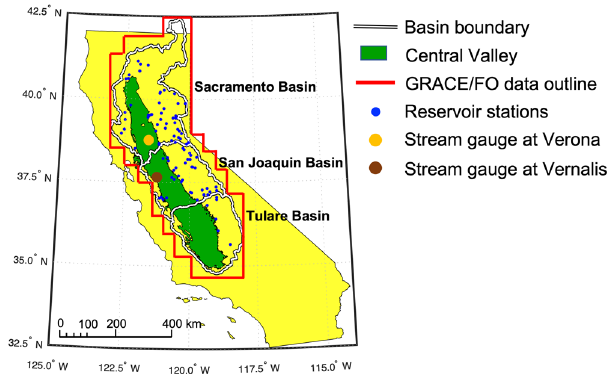
Fig. 1 | California ’ s Central Valley. The Central Valley (green) encompasses the Sacramento, San Joaquin, and Tulare Basins (black and white boundary). The red border outlines the area of GRACE/FO mascon data used for the study. Blue dots show locations of active reservoir storage gauges distributed within the study region, and the orange and brown dots show locations of the two main stream discharge gauges in Central Valley. The GRACE/FO data, reservoir storage and stream fl ow measurements are used to estimate groundwater storage changes as discussed in the Methods